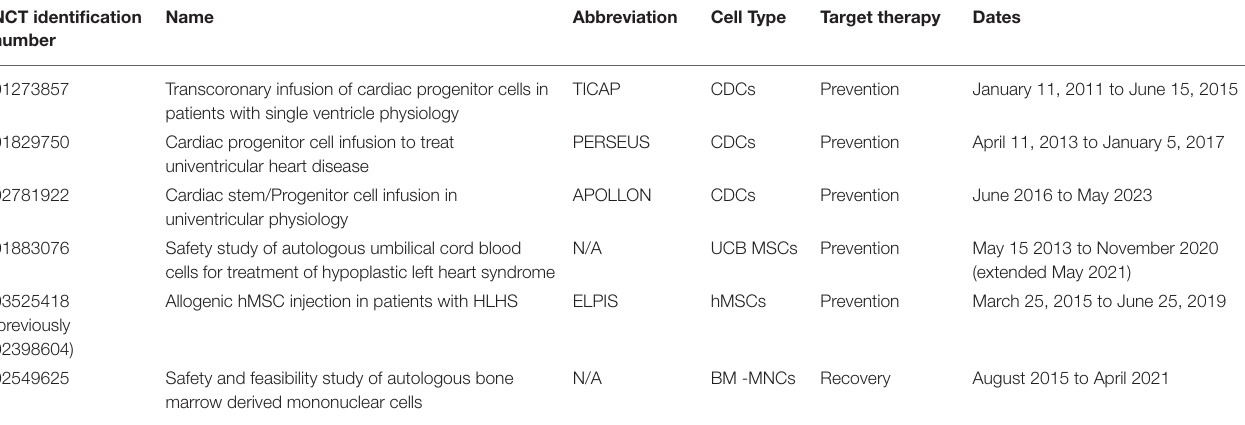
TABLE 3 | Clinical trials that have/are using stem cell therapies for prevention and recovery of the failed Fontan